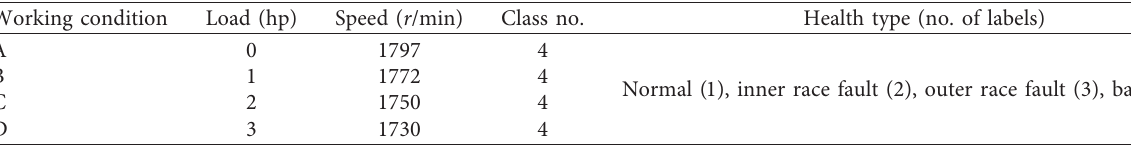
Figure 5: (a) Bearing test stand; (b) its structural diagram. Table 1: Description of the four working